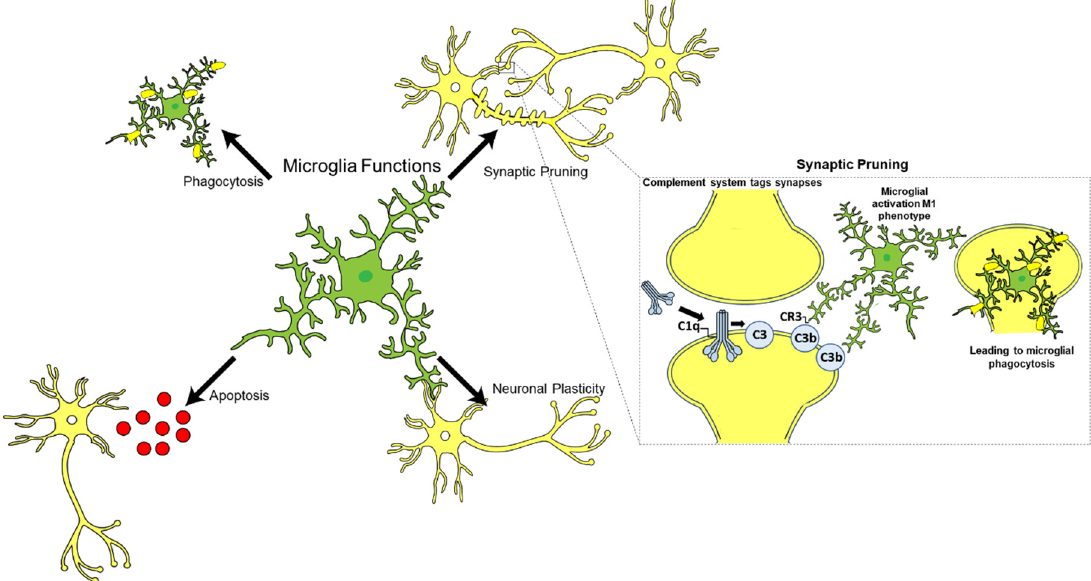
Figure 3. Microglial cells (shown in green) under physiological conditions have ramified appearance and are the resident immune cells of the central nervous system (neuronal cells shown in yellow). Microglia are involved in a variety of functions such as pruning of synapses, phagocytosis of pathogens, apoptotic and necrotic cells, and regulation of neurogenesis and neuronal plasticity, thus helping in overall effective functioning of the central nervous system. During development of the brain, synaptic pruning takes place where the complement system aids microglia in the removal of weak synapses. However, in AD, neurons and glial cells synthesise and secrete complement proteins such as C1q. C1q can bind to synapses and cause activation of the complement classical pathway leading to cleavage of C3 to yield C3b, an opsonin which will tag synapses. Microglia recognise the tagged C3b neurons via their CR3 receptor and phagocytose the neurons which can eventually lead to neurodegeneration. (Figure adapted from Dalakas, M.C.; Alexopoulos, H., Spaeth, P.J. Complement in neurological disorders and emerging complement-targeted therapeutics. Nat Rev Neurol. 2020, 16,